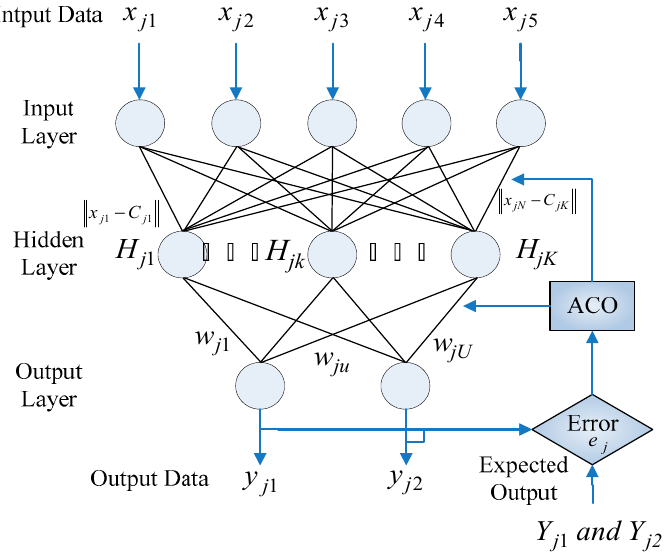
Figure 1. The ARBFN structure j -th model.